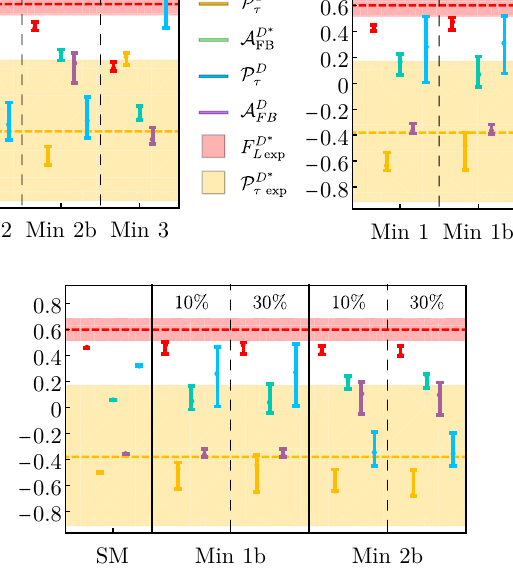
in the fit. The L and the